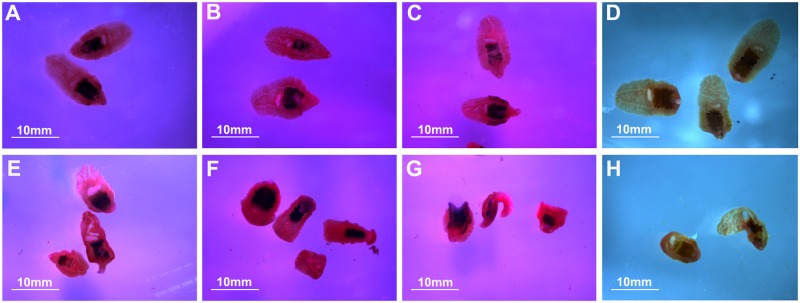
Morphological and moving changes of C. sinensis adults with or without MB05032 treatment.Adult flukes were maintained on high glucose DMEM (A), high glucose DMEM + MB05032 (E), low glucose DMEM (B), low glucose DMEM + MB05032 (F), no glucose DMEM (C), no glucose DMEM + MB05032 (G), 1 × Locke’s (D), and 1 × Locke’s + MB05032 (H), respectively. The images were captured at 5 d of feeding and magnified at × 32.